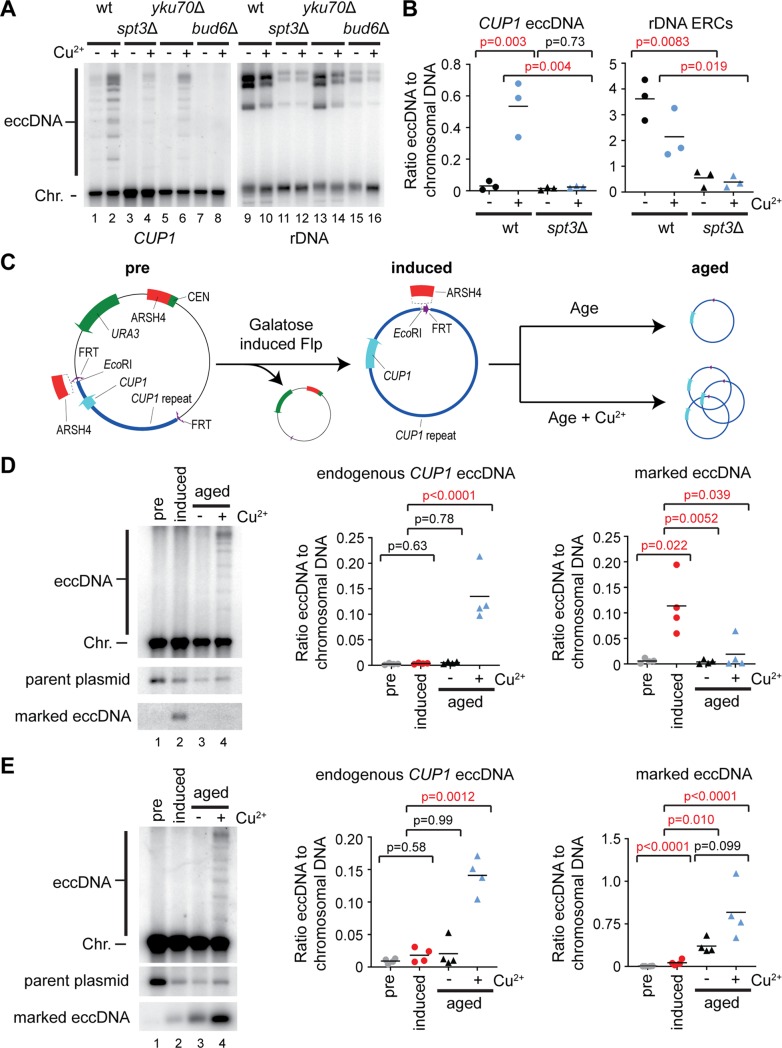
Asymmetric inheritance is necessary but not sufficient for eccDNA accumulation.(A) Southern blot showing CUP1 eccDNA and ERCs for wt, spt3Δ, yku70Δ, and bud6Δ cells aged for 24 hours in the presence or absence of 1 mM CuSO4. (B) Quantification of CUP1 eccDNA and rDNA-derived ERCs in wt and spt3Δ cells aged for 24 hours in the presence or absence of 1 mM CuSO4, performed and analysed as in Fig 1B, n = 3. (C) Schematic representation of method to form and quantify marked CUP1 eccDNA. Briefly, galactose-inducible Flp recombinase is used to excise a marked CUP1 eccDNA with an EcoRI site absent from endogenous CUP1 repeat region. Distribution of the marked eccDNA and endogenous species after 24 hours of ageing can be quantified by Southern blot. A variant carrying an additional ARSH4 sequence within the marked eccDNA was also constructed as shown. (D) Marked eccDNA analysis: MEP wt cells cured of 2μ were transformed with one plasmid carrying a CUP1 repeat and an EcoRI site flanked by FRT sites and a second plasmid expressing Flp from a galactose-responsive promoter. Cells were grown overnight in selective media to maintain plasmids and containing sucrose and raffinose as carbon sources (lane 1, pre). Flp expression was induced by addition of galactose for 4 hours, then cells were labelled, inoculated in 3 cultures, and grown in nonselective glucose media for 2 hours after which 1 culture was harvested (lane 2, induced); 1 mM CuSO4 was then added to 1 culture, and both cultures were grown for 24 hours at 30°C before harvesting (lanes 3–4, aged). EcoRI-digested genomic DNA was analysed by Southern blot and probed for the CUP1 repeat to reveal all species shown. Marked and endogenous CUP1 eccDNA was quantified; band intensities were log transformed to fulfil the assumptions of a parametric test and analysed by one-way ANOVA, n = 4 biological replicates. (E) Modification of marked eccDNA experiment: the ARSH4 origin of replication was cloned into the marked CUP1 plasmid between the EcoRI site and the CUP1 repeat sequence such that ARSH4 remains in the marked CUP1 eccDNA after Flp recombination (see schematic in panel C). Experiment was performed exactly as in panel D. The data underlying this figure may be found in S1 Data and S1 Raw Images. eccDNA, extrachromosomal circular DNA; ERC, extrachromosomal ribosomal DNA circle; FRT, flippase recognition target; MEP, mother enrichment program; rDNA, ribosomal DNA; wt, wild type.